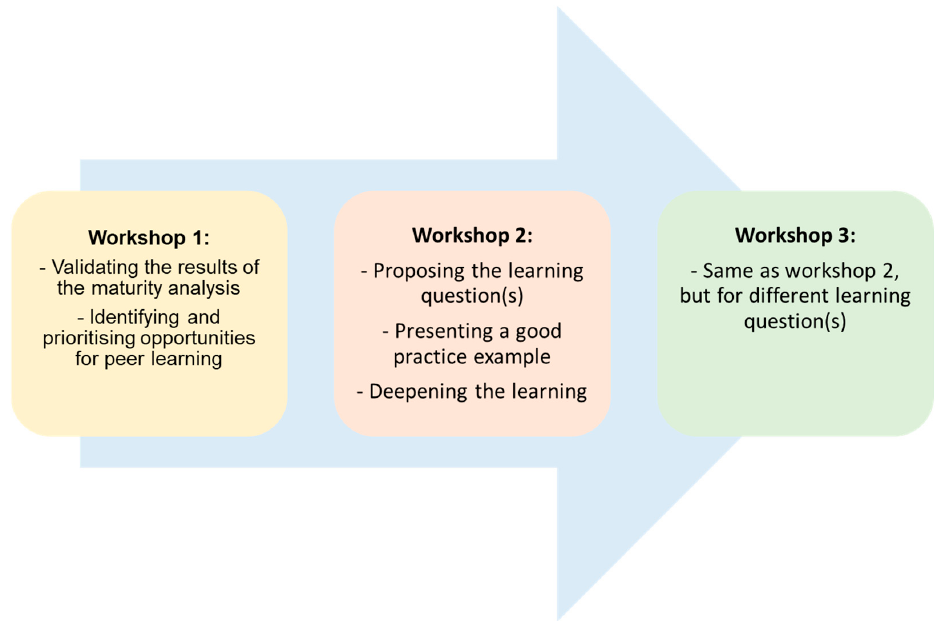
Figure 3. Design of the peer learning workshops.